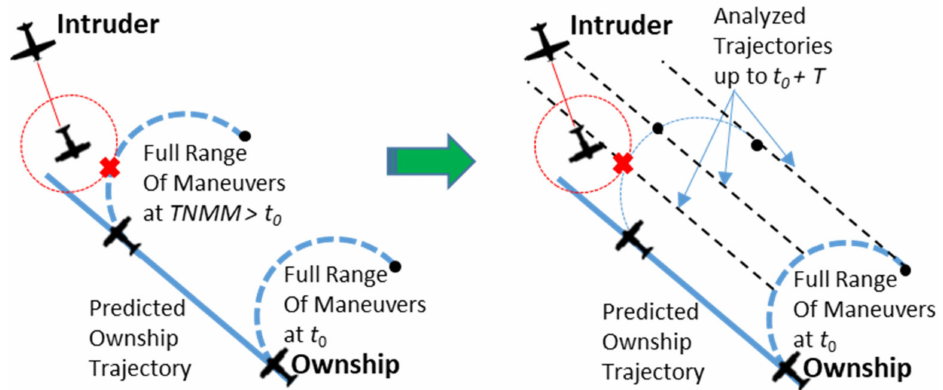
Figure 9. Computation of TNMM for horizontal maneuvers.